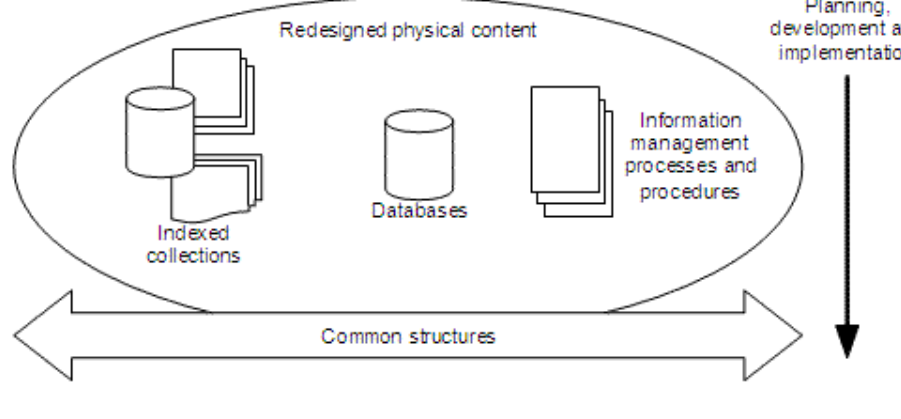
Figure 4 Planning, development and implementation (adapted from Fisher